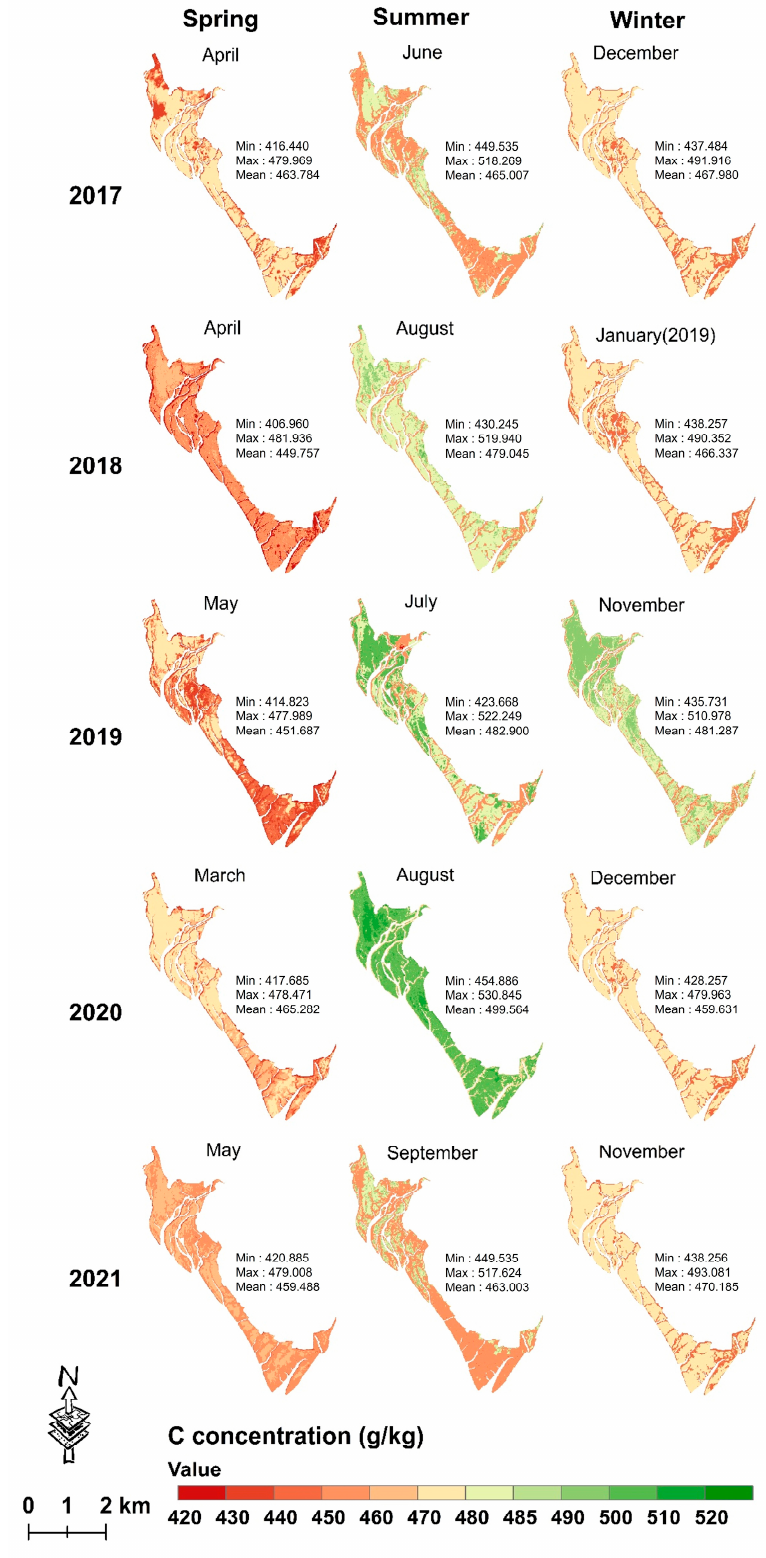
Figure 8. Seasonal leaf C mapping from 2017 to 2021 using the XGBoost model with the dataset of a single